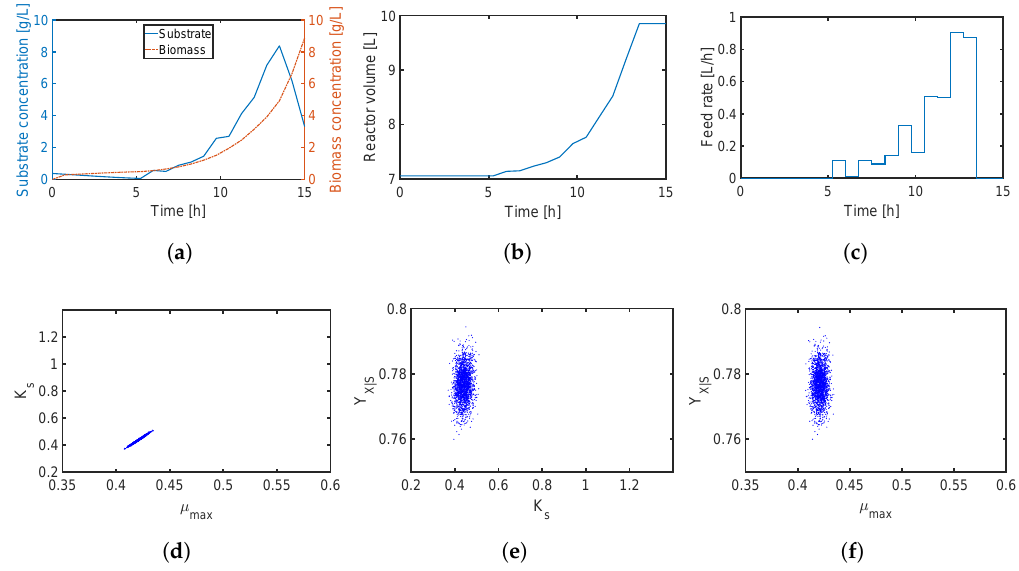
Figure 10. Evolution profiles for three states (( a ) biomass concentration, substrate concentration; and ( b ) volume of the reactor) and ( c ) the feed rate for the adapted Shannon-entropy-based design with w = [ 1000,0.1,0,1 ] T . In ( d – f ), the resulting parameter estimates are shown.